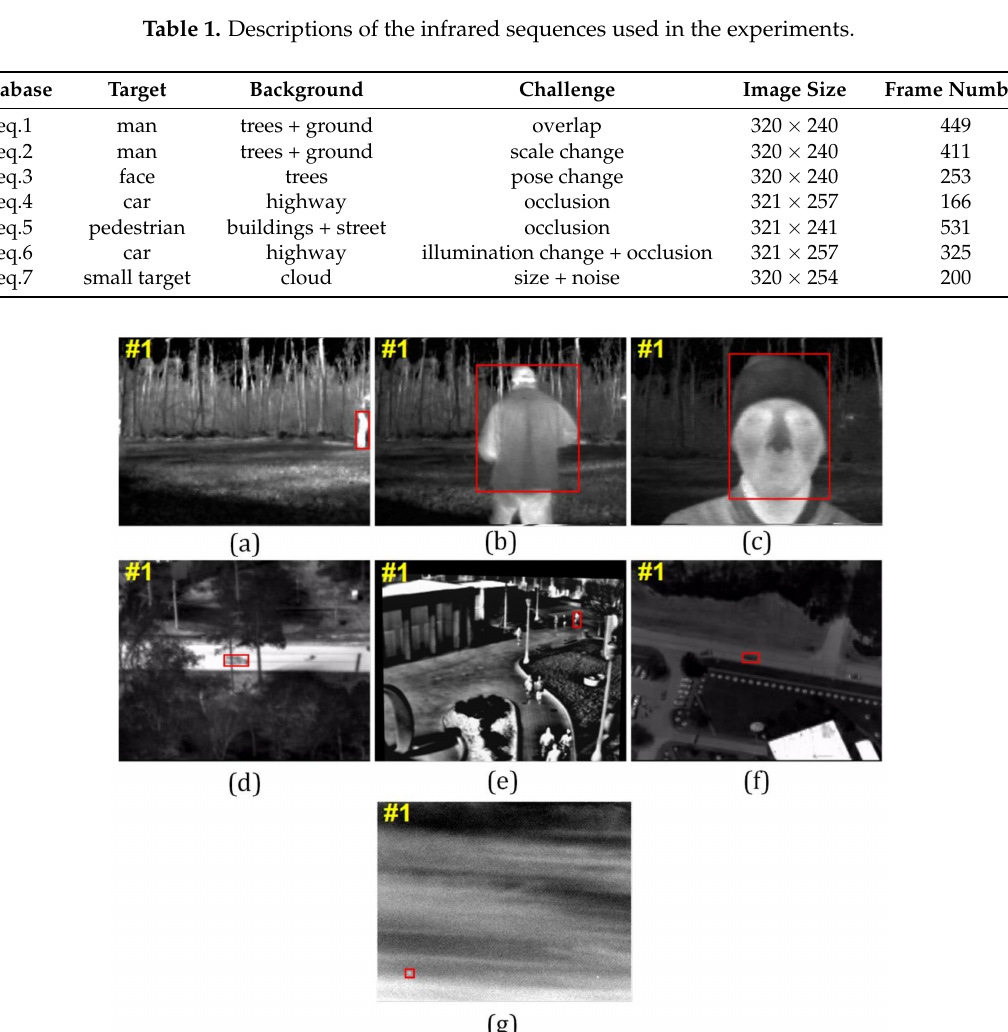
Figure 1. The first frame with the target marked in a red rectangle. ( a ) Seq.1; ( b ) Seq.2; ( c )